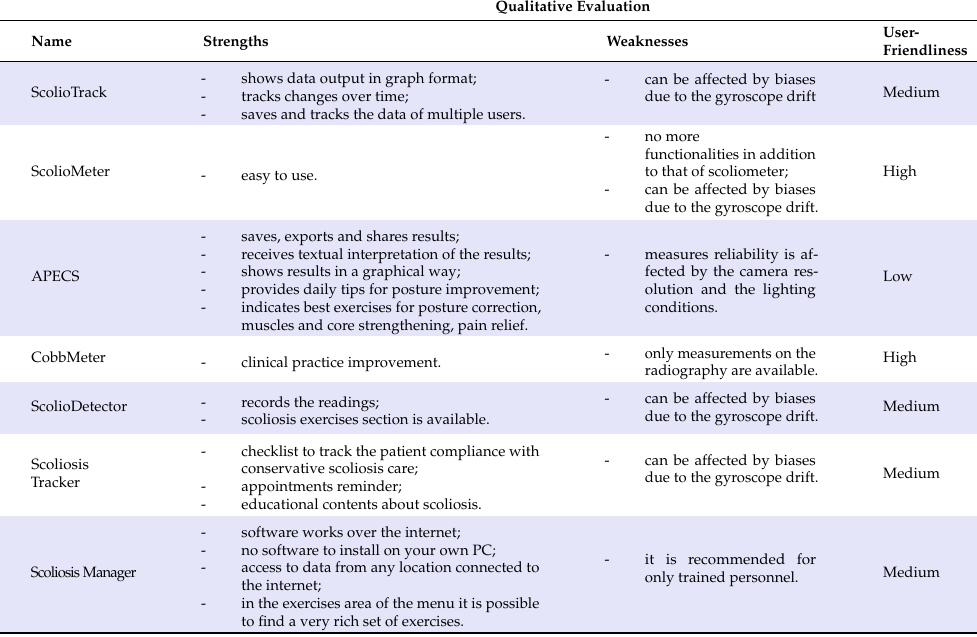
Table 4. Comparison of the tools with respect to Qualitative Evaluation macro-category. Note that all the tools have a high user-friendliness and their weaknesses are due to the type of the used sensors (i.e., camera-based or